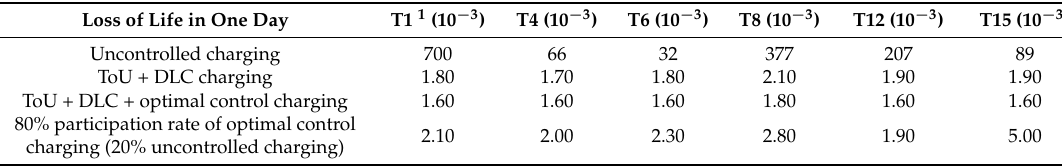
Table 2. Distribution transformer internal insulation loss of life in one day